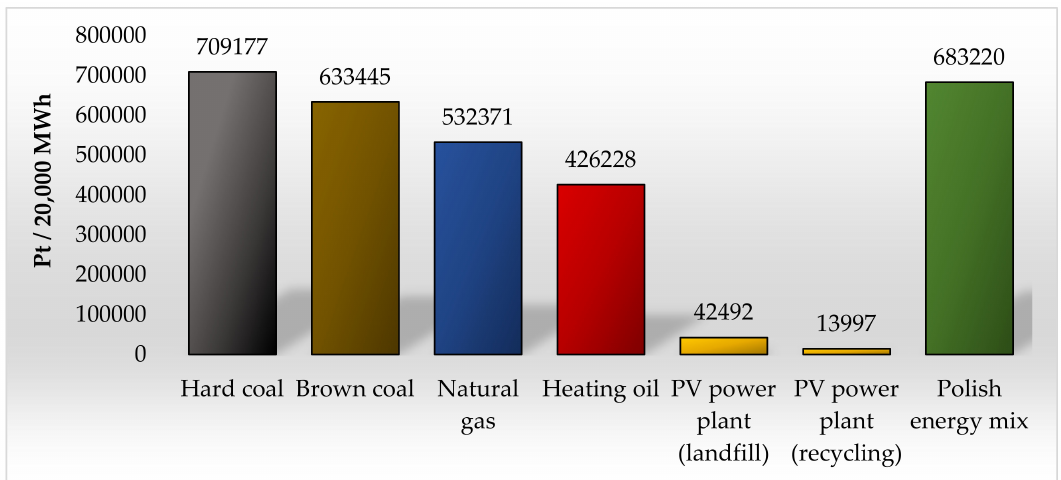
Figure 9. Results of grouping and weighting environmental consequences arising as a result of generating 20,000 MWh of electricity from selected energy sources [unit: Pt].